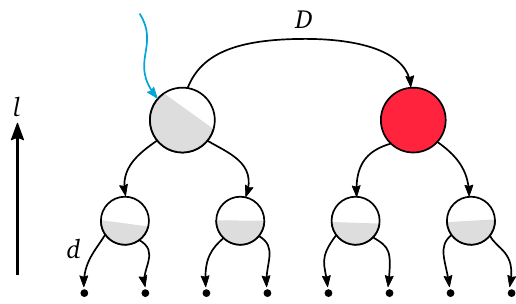
Figure 47: A binary TTN: The black dots at the bottom represent the physical sites of local dimension d . Each link in the l -th layer (counting from below towards the top) has dimension min ( d 2 l , D ) , where D is a constant that we will refer to as the bond dimension . The dangling blue link at the top left tensor has dimension one and carries the global symmetry sector of this symmetric TN state. Its position in the network can be arbitrarily chosen. All tensors are gauged towards a center node